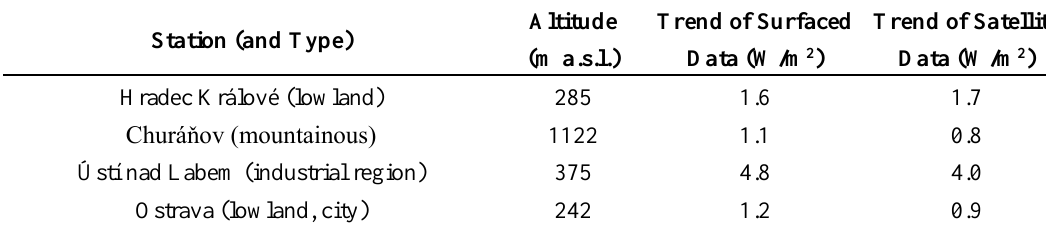
Figure 5. Map of the decadal trend of SIS in the Czech Republic from the SARAH dataset (1983–2013). Table 2. Decadal trends of SIS for selected stations in the 1983–2013 period. Values for surface stations and for the closest points were derived from SARAH